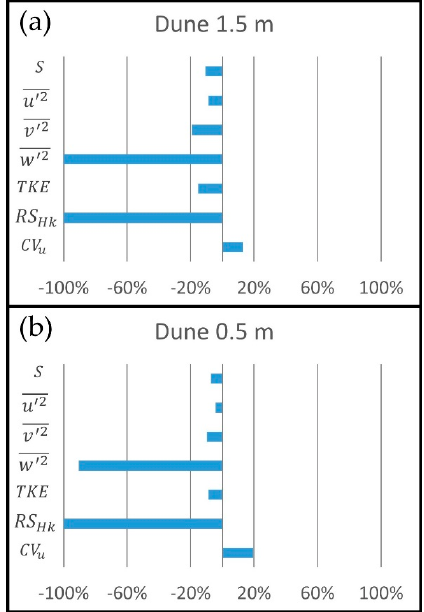
Figure 13. Percent difference in normalized flow quantities over the stoss slope of the foredune (calculated as: (T1 − T2)/T2B 1.5 ) between similar anemometer locations on T1 (LWD) and T2 (no LWD) over all runs and flow quantities: resultant 3D wind speed ( S , m s − 1 ), normal kinematic Reynolds stresses ( u (cid:48) 2 , v (cid:48) 2 , w (cid:48) 2 , m 2 s − 2 ), turbulent kinetic energy (TKE, m 2 s − 2 ), horizontal kinematic Reynolds stress ( RS Hk , m 2 s − 2 ), and the coefficient of variation (CV u ). Top: Dune-1.5 m (excludes incomplete datasets from runs 6–8), Bottom: Dune-0.5 m.